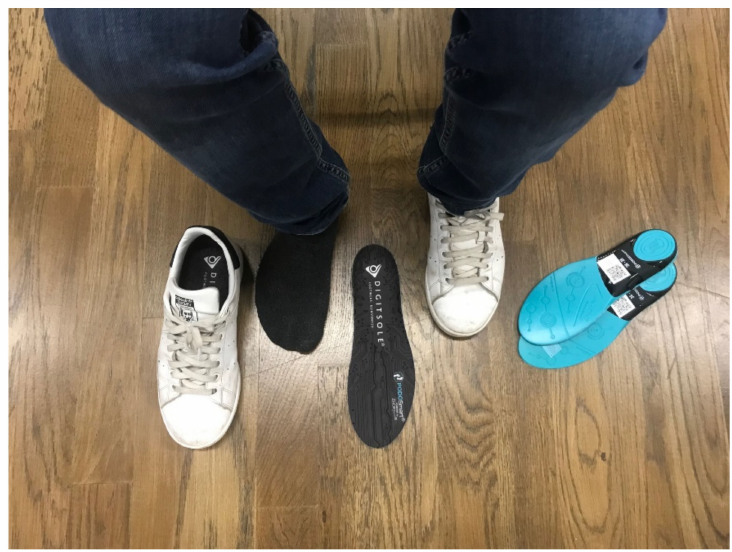
Figure 2. Subject preparation and PODOSmart ® insoles